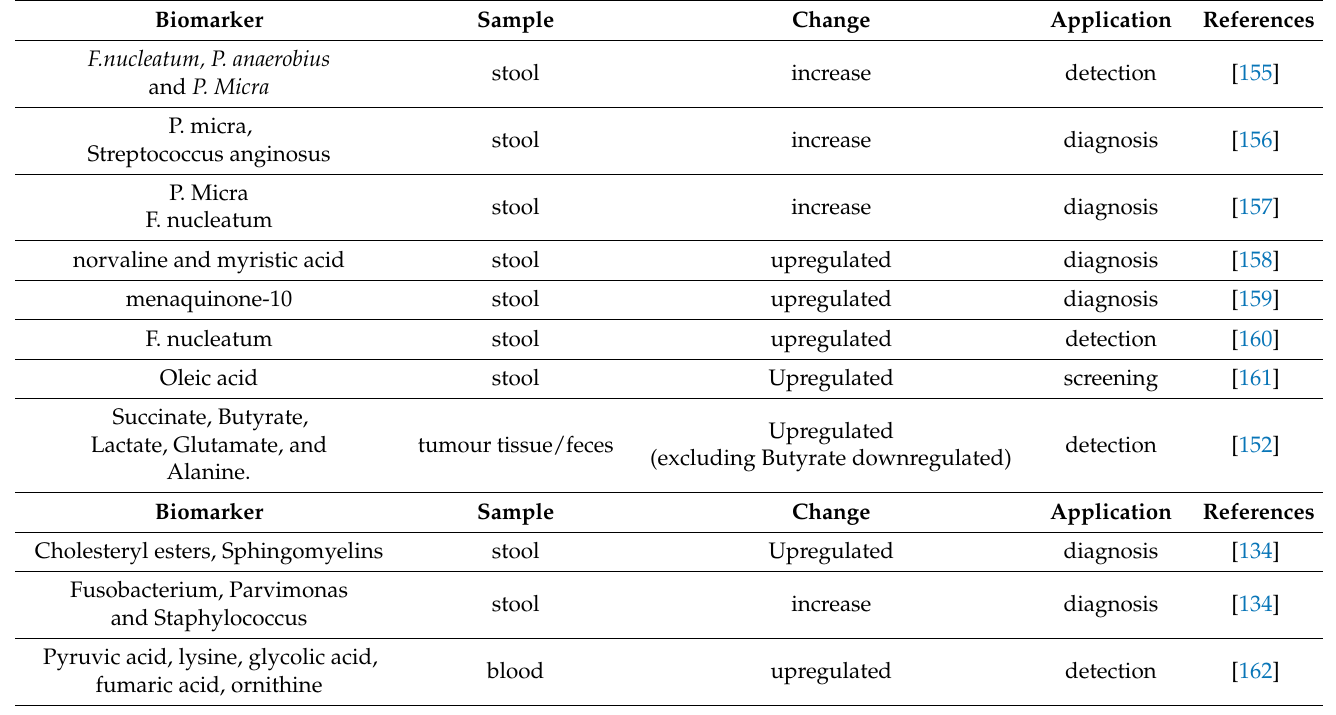
Table 4. Potential multi-omics base microbiomics and metabolomics biomarkers in